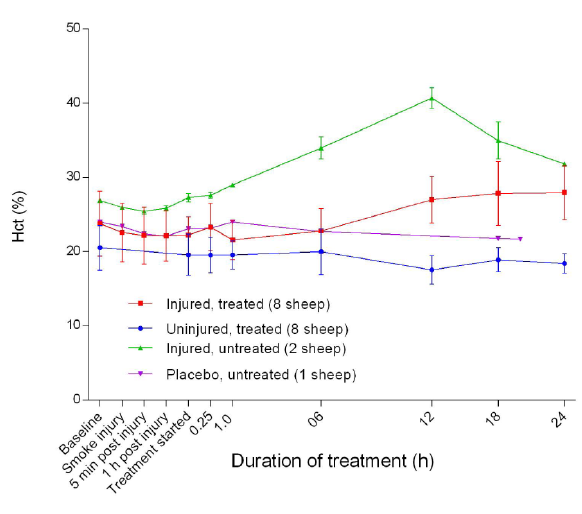
Figure 12. Calculated haematocrit (Hct) (%) (Mean ± SD) in smoke and non-smoke injured sheep that received extracorporeal life support as compared to that in untreated controls.